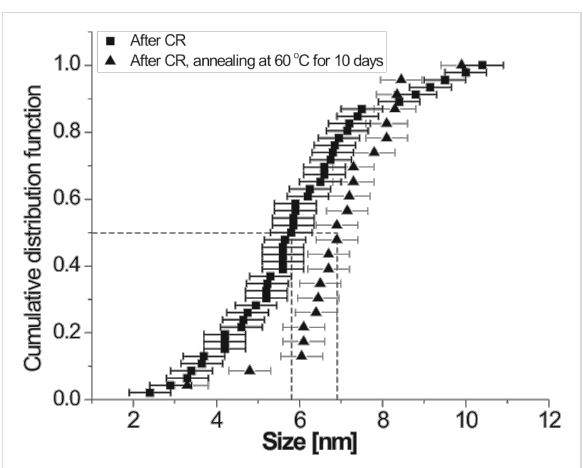
Figure 3: The cumulative size distribution for Al nanocrystals inside shear bands. Square markers represent measurements on samples that were only cold-rolled. Triangular markers represent samples that were cold-rolled and annealed at 60 °C for 10